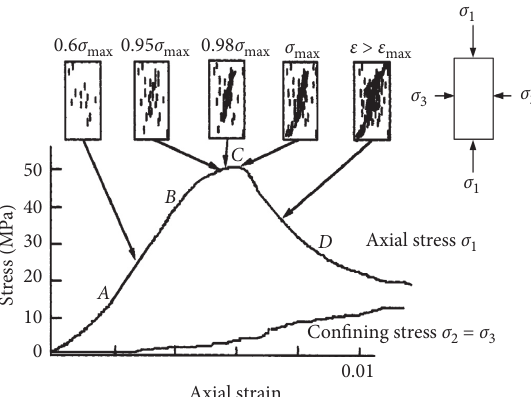
Figure 1: The stress-strain curve of argillaceous quartzite speci- mens and cartoons of the state of microcracking observed on specimens [14].